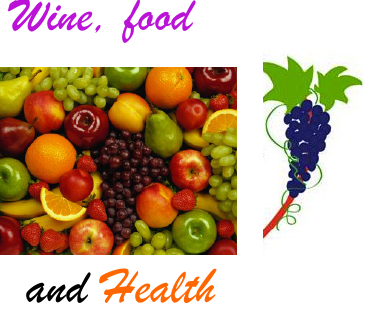
Figure 1. Figure of the Figure 1 of the authors.